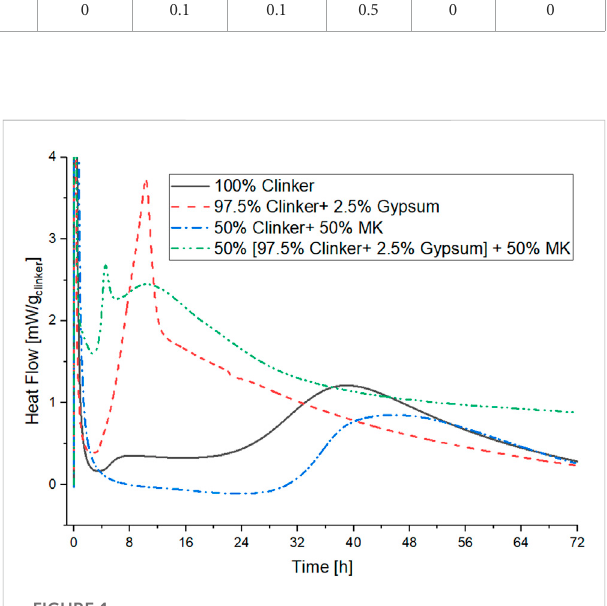
FIGURE 1 Heatreleaseratepermassofclinkerduring hydration ofPortland cement clinker without and with gypsum and